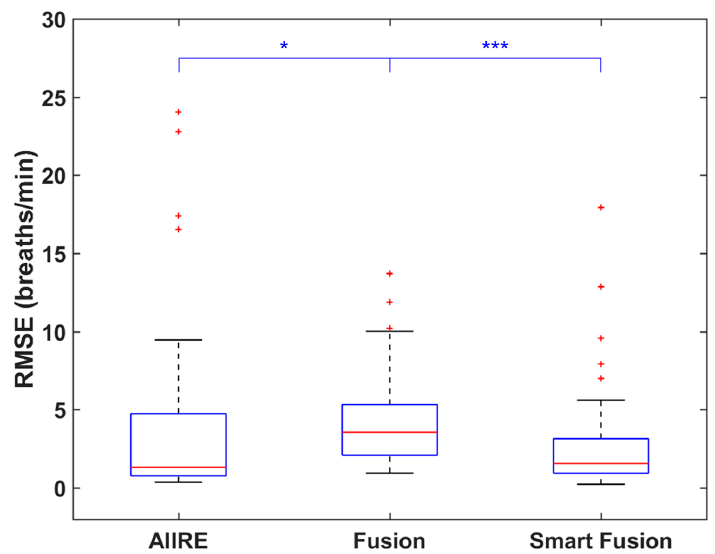
Figure 5. Distributions of root mean square errors (RMSEs) of respiratory rate (RR) estimation results when the proposed method and the smart fusion algorithms were applied to the same dataset. Lower quartile, median, and upper quartile values are displayed in the box plots. Whiskers are used to represent the most extreme values within 1.5 times the interquartile range from the quartile. Outliers are displayed as crosses. * ( p < 0.05) and *** ( p < 0.001) represent a statistically significant difference.